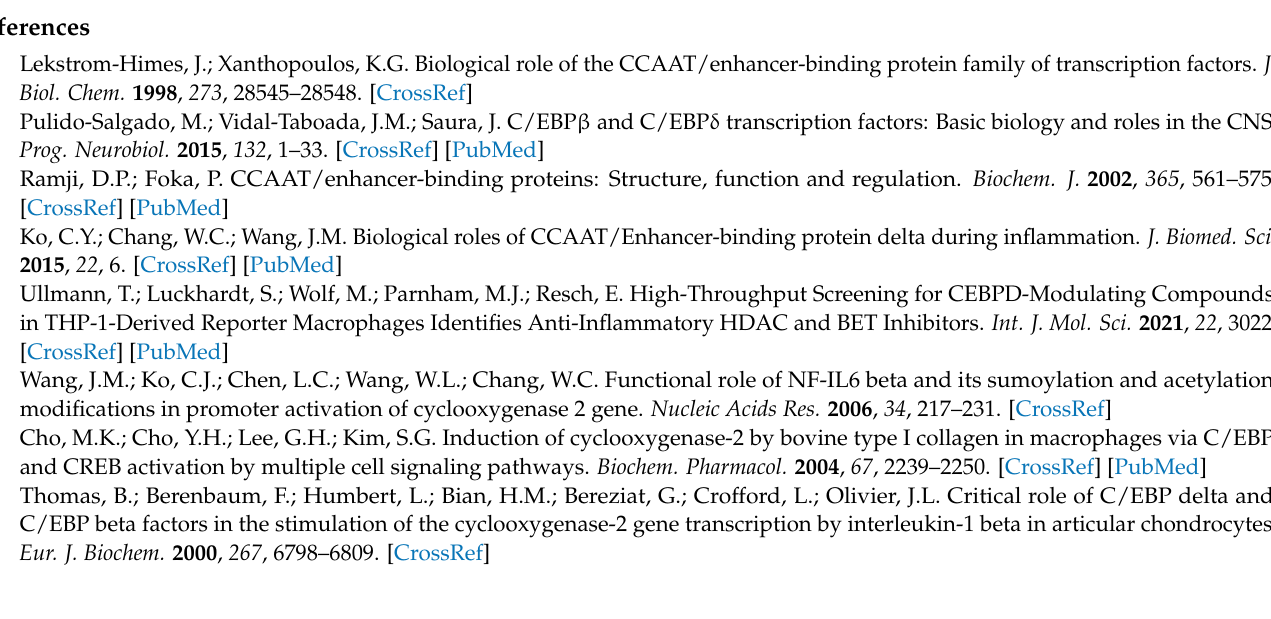
Figure S2: DNA sequence of wild-type, C/EBP δ knock-out and C/EBP δ ∆ TAD RAW264.7 clones, Figure S3: Relative CEBP and NF-Y family member expression in monocytes and macrophages,